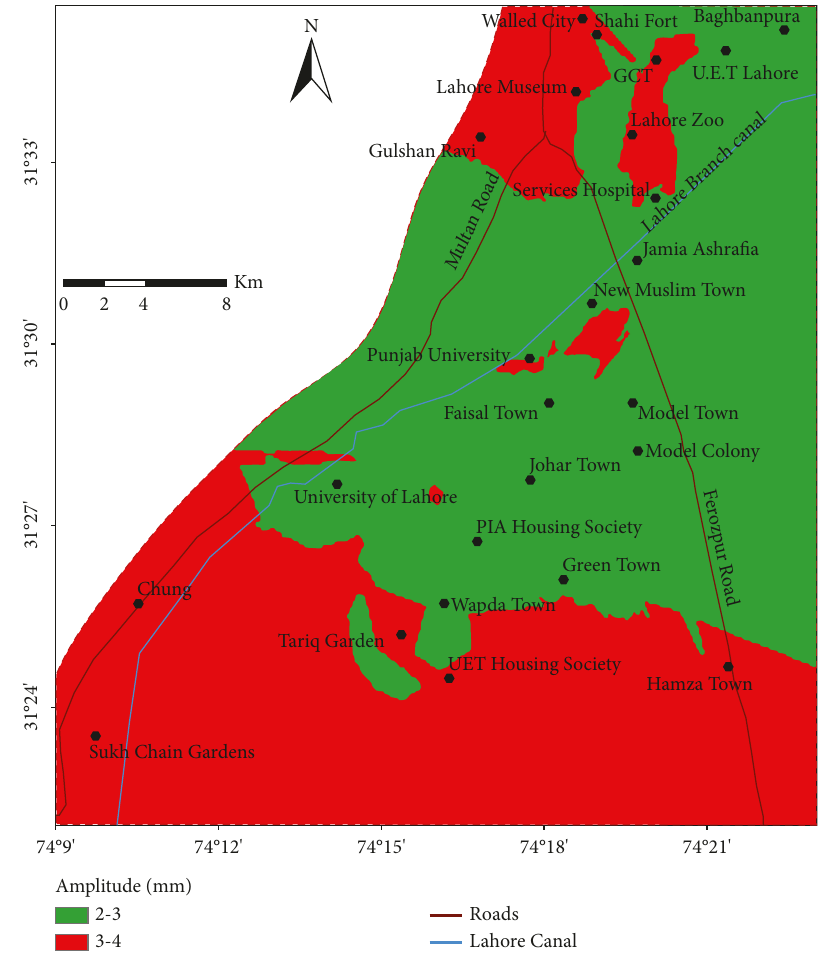
Figure 10: Spatial distribution of peak amplitude in the study area characterizing into low and high